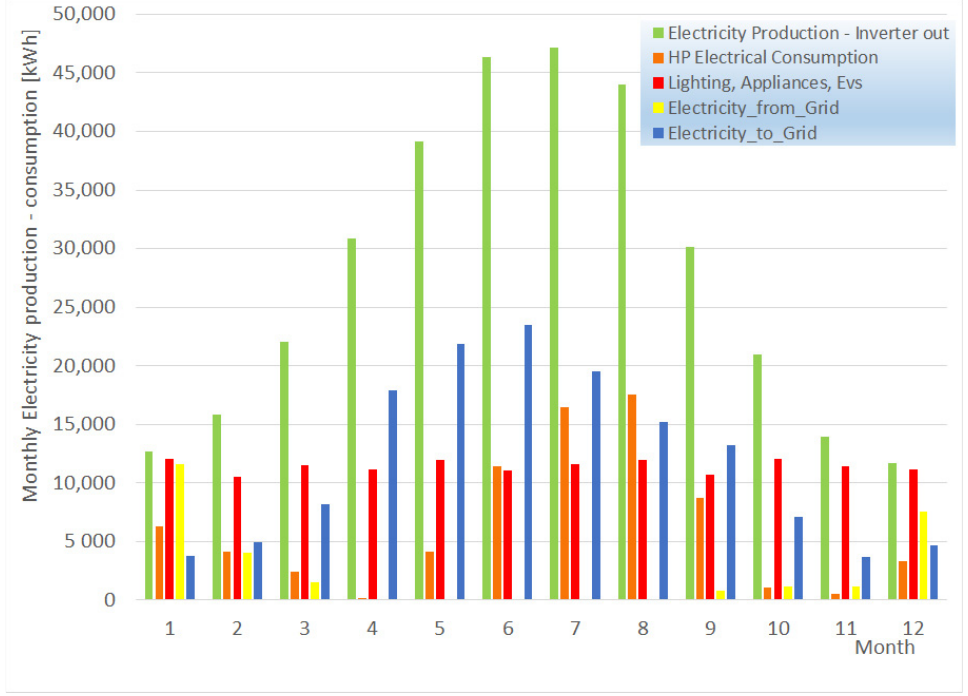
Figure 3. Monthly electricity production and consumption during one full year (car charging in- cluded).